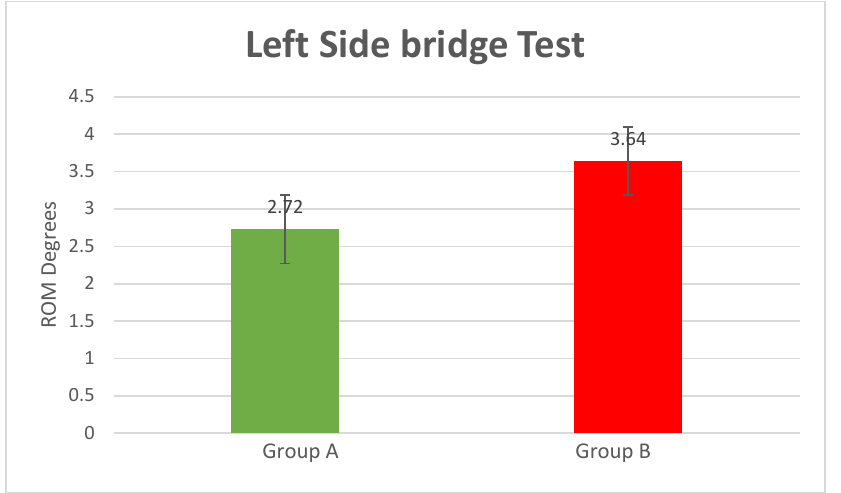
Figure 6. Left-side bridge test results ( p -value = 0.0004). Right-Side Bridge Test The position obtained during the execution of the right-side bridge test was left lateral flexion (compared to the neutral position), with the patients measured at: mean = 2.45° of left lateral flexion SD = 0.58 for Group A and mean = 3.44° of left lateral flexion SD = 0.85 for Group B ( p -value = 0.00002) (Figure 7).